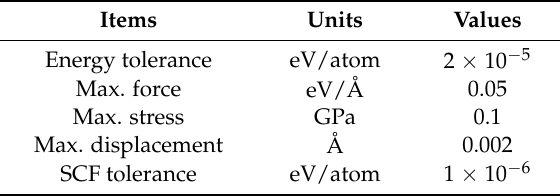
Table 1. Convergence criteria for the simulation work. Items